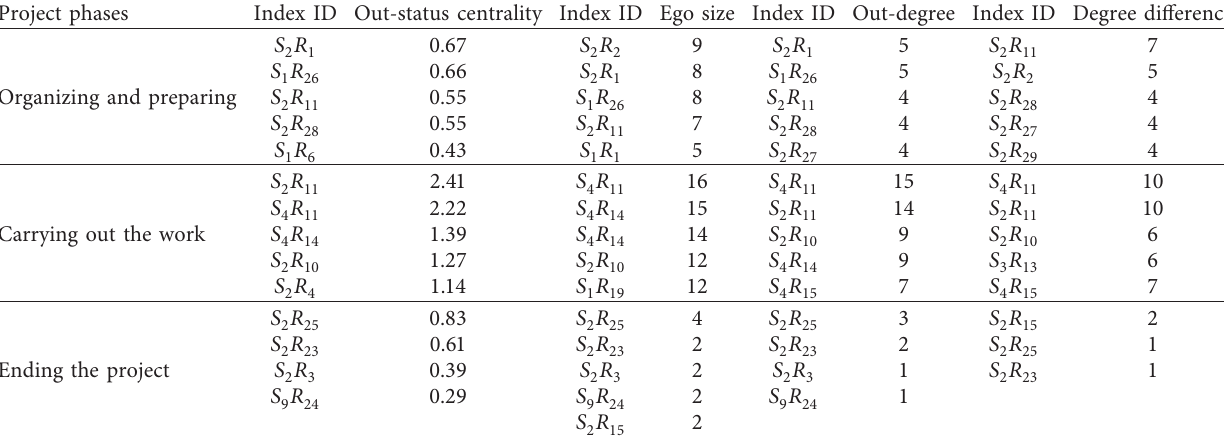
Table 4: Ranking of key risks based on state centrality, self-network, and node degree analysis. Project